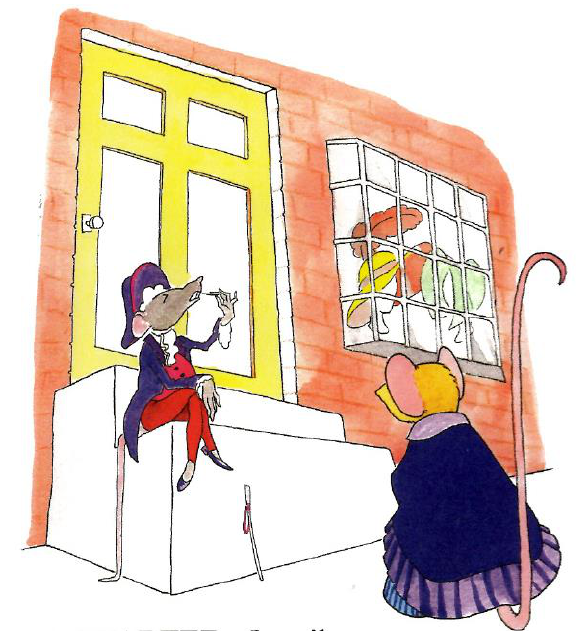
Figure 10. McMaster’s illustration for The Beautifull Cassandra (Austen 2021), p. 23. McMaster sharply contrasts this image of Cassandra’s father with that of her